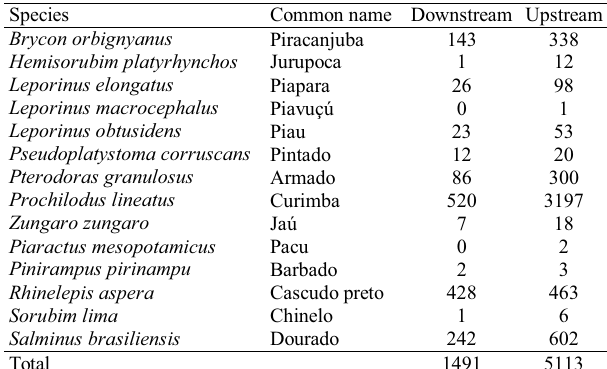
Table 1. Number of fish tagged and released in the regions downstream and upstream from the Porto Primavera Dam, during the period from 1994 to 1998.